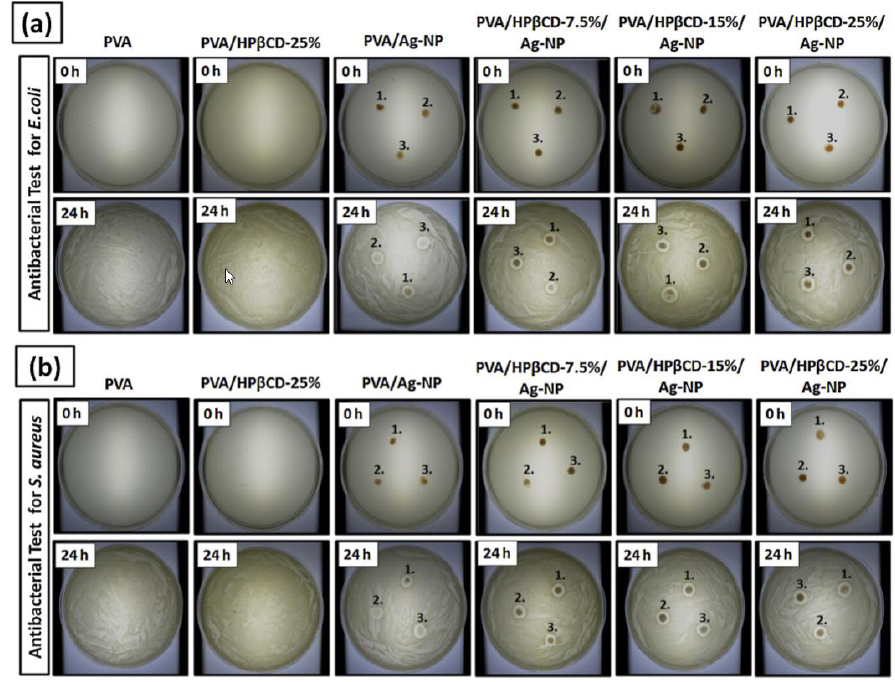
Figure 3. The photographs of antibacterial testing of nanofibrous mats that were performed against ( a ) E. coli and ( b ) S. aureus . Reprinted from [97], Copyright 2014, with permission from Elsevier.